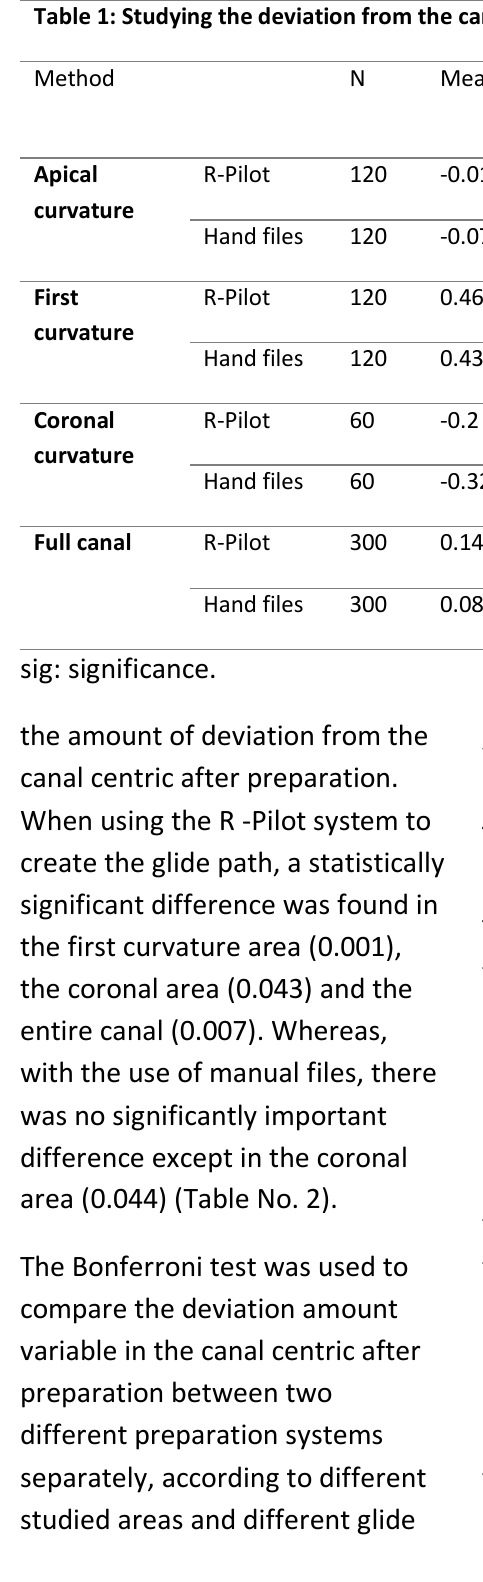
First curvature Coronal